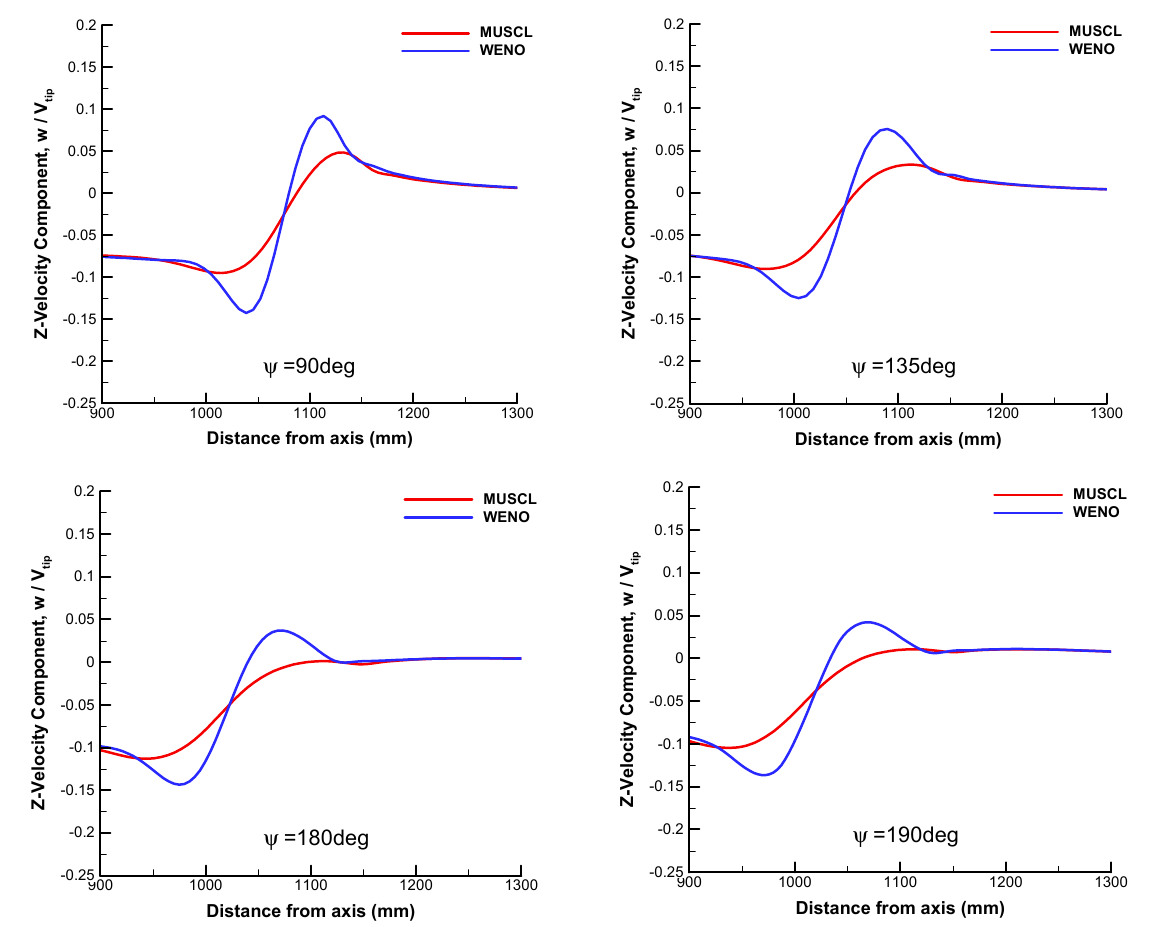
Figure 11. Comparison of velocity profiles at different wake age angles.